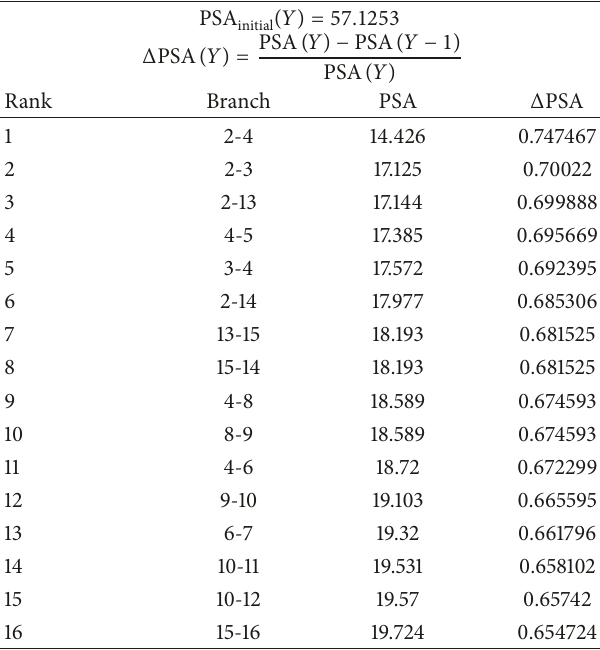
Table 1: Critical branches rankings in UKGDS